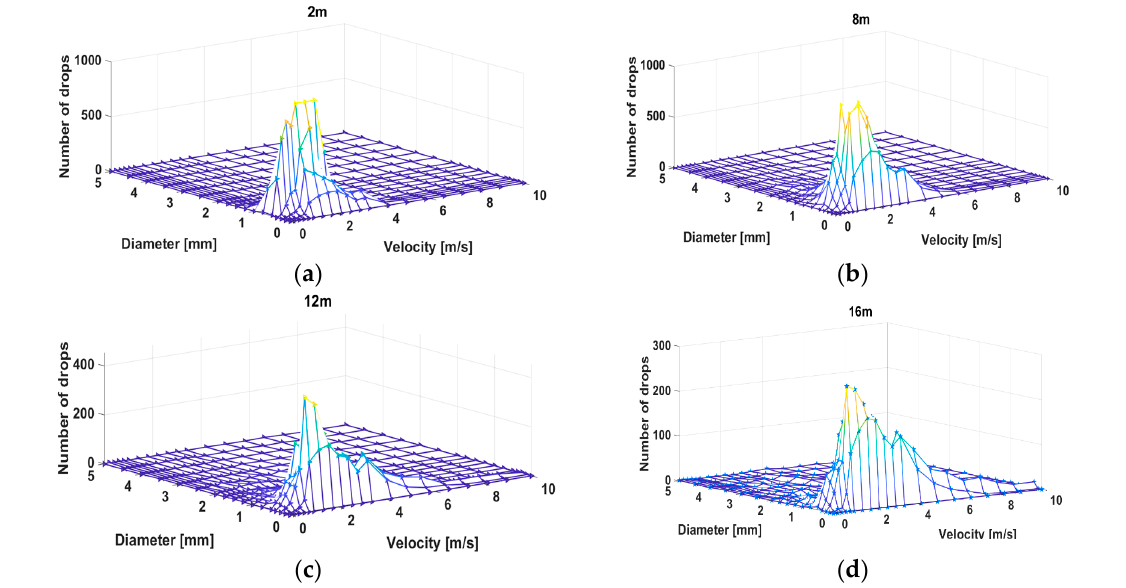
Figure 2. Graphical representation of the relationship between the number, diameter, and velocities of drops collected with the Thiess Clima Laser Precipitation Monitor (TLCPM) at different distances from the sprinkler nozzle... ( a ) Measured at 2 m, ( b ) measured at 8 m, ( c ) measured at 12 m and ( d ) measured at 16m respectively from the sprinkler at operating pressure of 300 kPa.